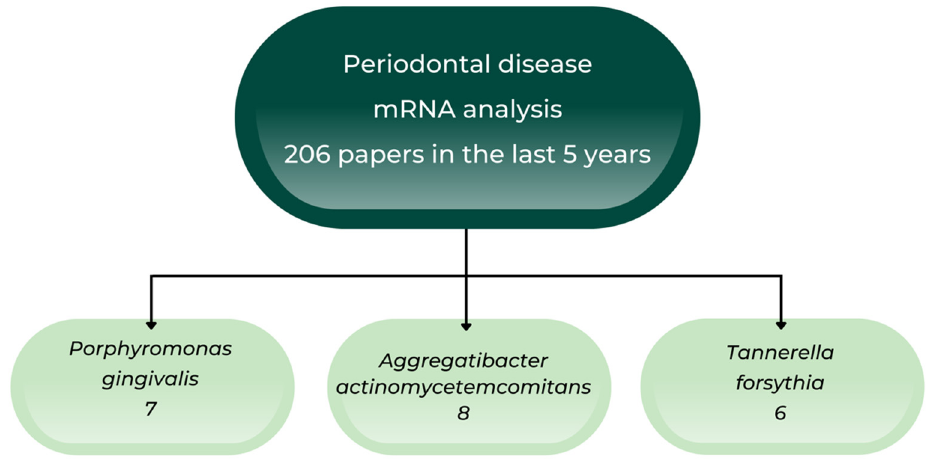
Figure 1. Diagram of analyzed studies.